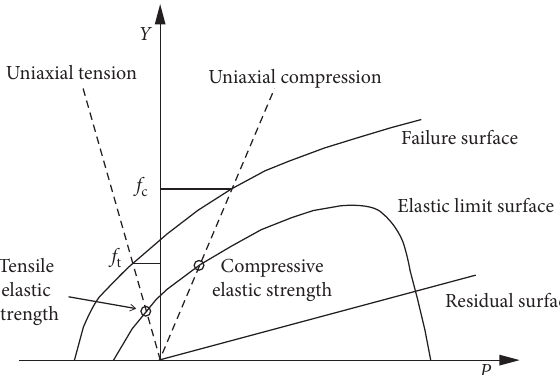
Figure 16: Maximum strength, yield strength, and residual strength